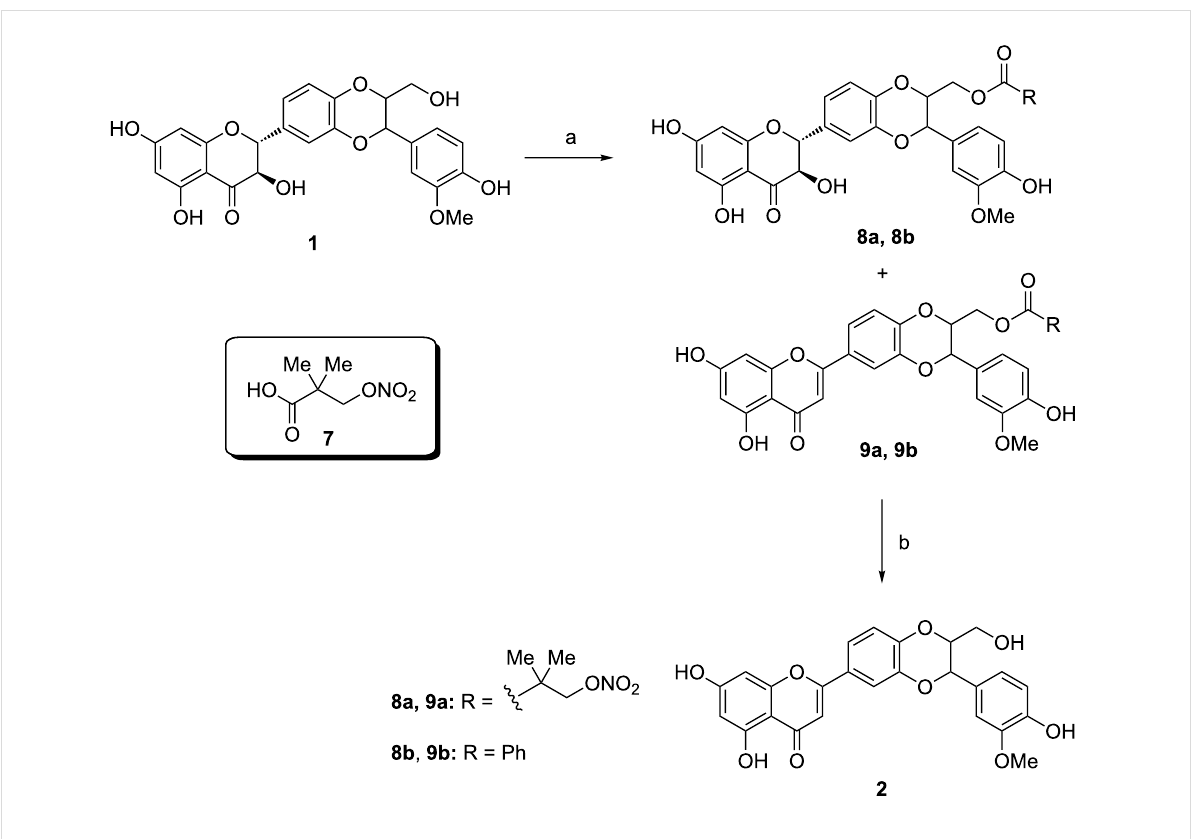
Scheme 1: Synthesis of ester derivatives of silibinin and conversion to hydnocarpin-type compounds. Reaction conditions: a) 7 or benzoic acid, Ph 3 P, diisopropyl azodicarboxylate (DIAD), THF, 10 °C to rt, 3 h.; b) LiOH·H 2 O, MeOH/H 2 O, rt, 2